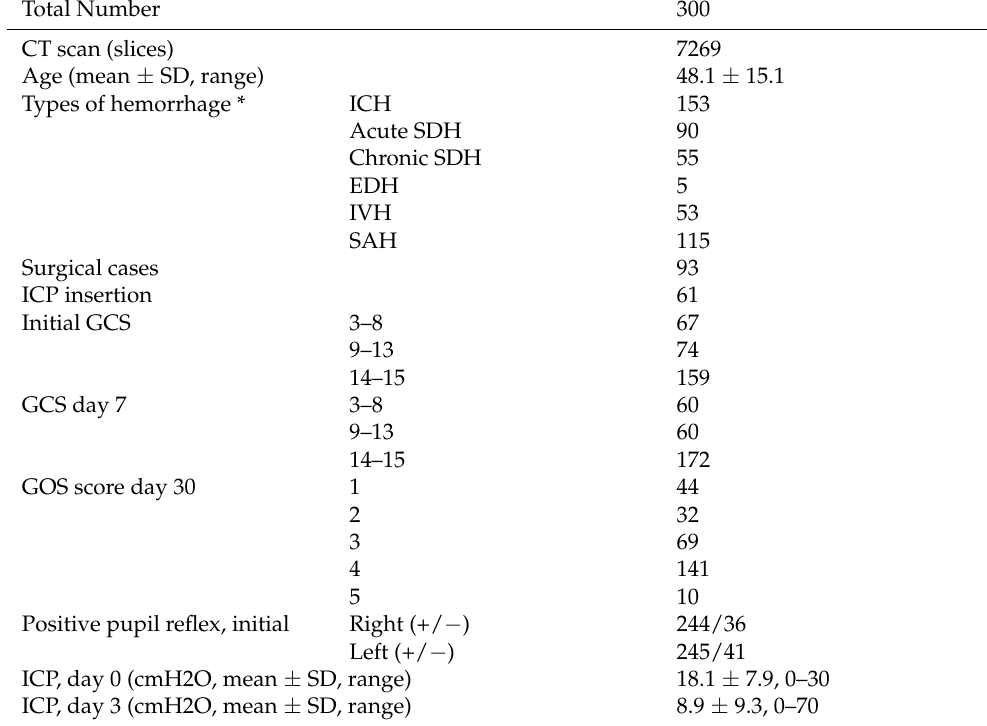
Table 1. General Characteristics.